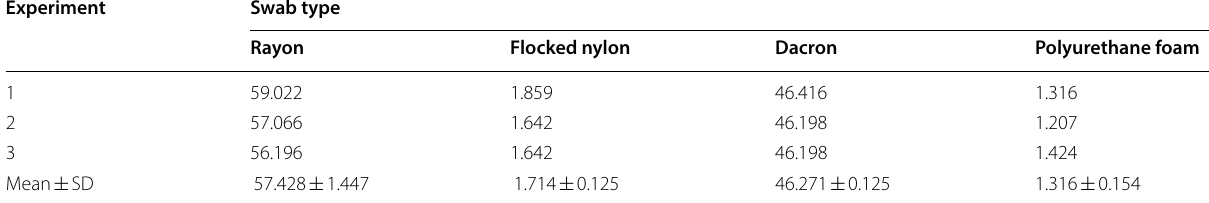
SD standard deviation